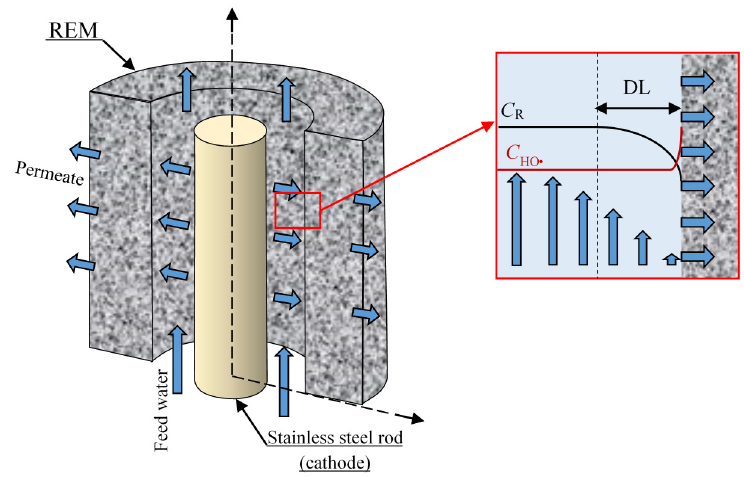
Figure 1. Schematic representation of the system under study. C R represents the concentration of an organic compound. The red square shows the area taken into consideration for the model: the electrode and the diffusion layer (DL).